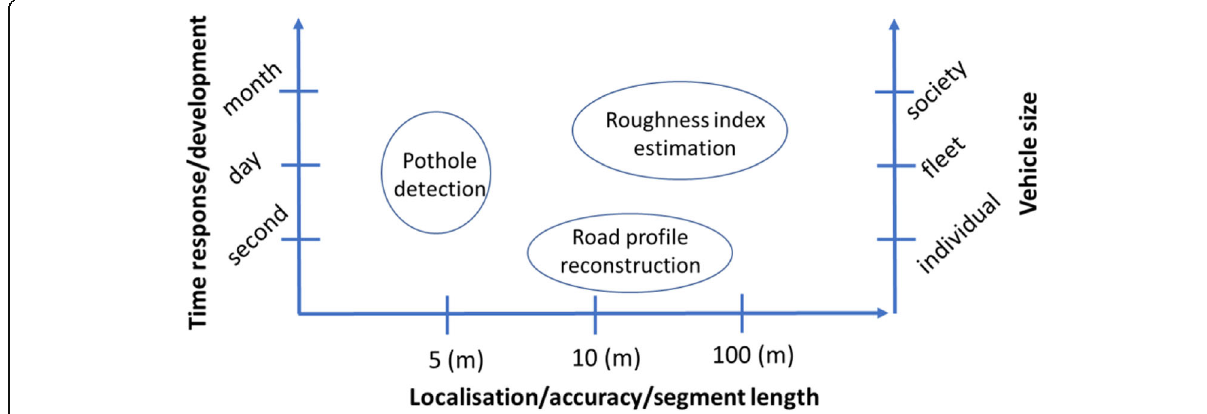
Fig. 1 Three temporal-spatial functions using response-based